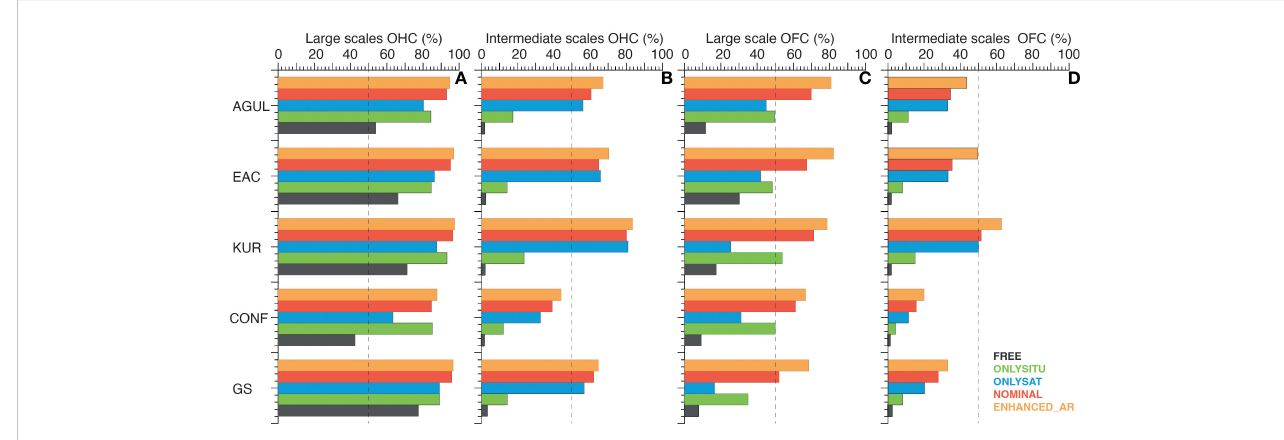
FIGURE 7 Percentage of the Nature Run represented variance, area-averaged in western boundary current regions, for 0-700 m Ocean Heat (OHC, A, B ) and Freshwater Contents (OFC, C, D ) at mesoscale and larger scales based on the FREE (black), NOMINAL (red), ONLYSAT (blue), ONLYSITU (green) and ENHANCED_AR (orange)